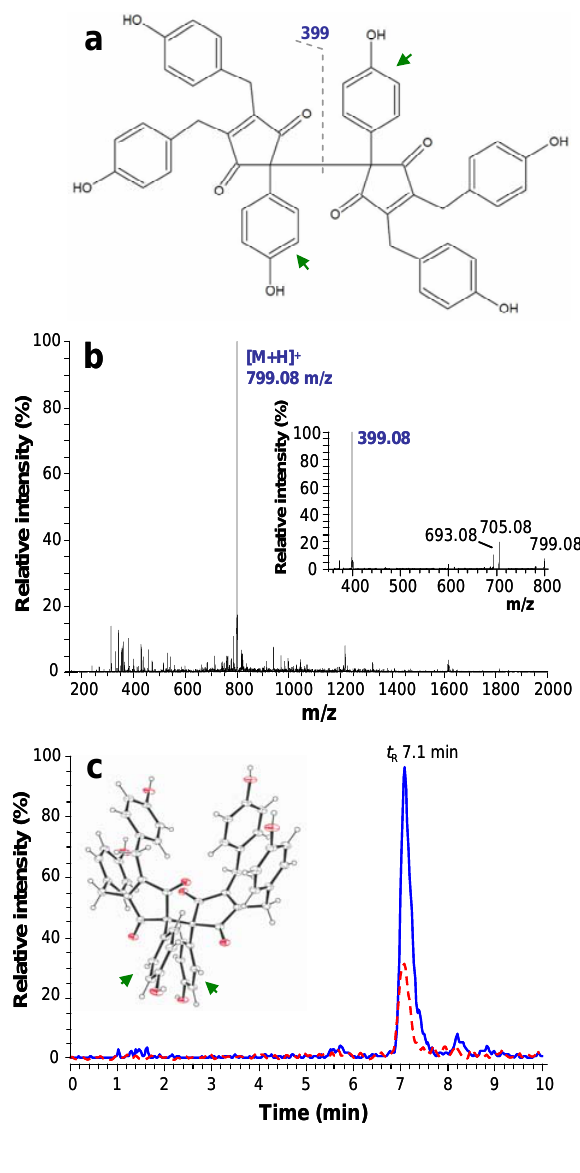
Figure 1. (a) Chemical structure and (b) full MS spectrum of NOS-6. (c) Chromatographic records of NOS-6 in homogenate prepared from mouse fibroblasts (BALB/c cells), after 4 h cultivation with 1 μ M NOS-6 (dashed line: NOS-6 model standard solution; 1 μ g·mL − 1 ). The MS 2 spectrum and 3-D molecular structure of NOS-6 are shown in insets of panel b and c ,